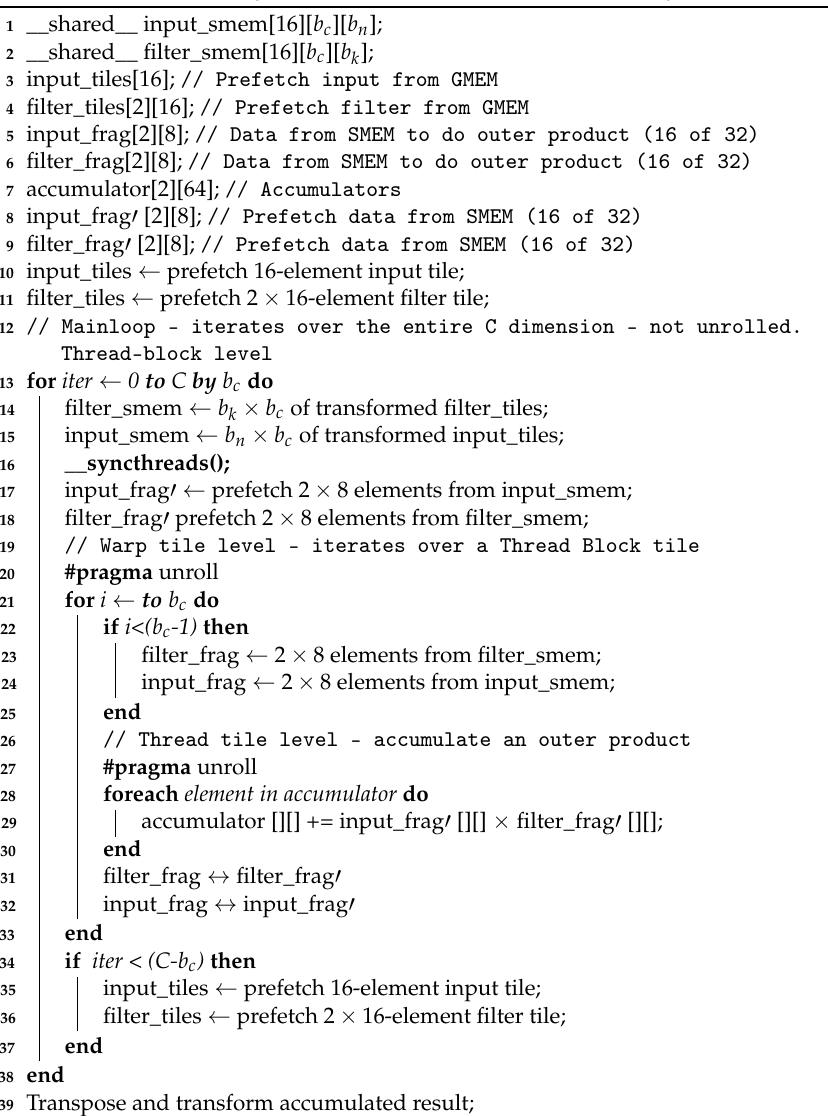
Algorithm 1: Pseudocode of the Winograd’s algorithm implementation for α = 4. SMEM stands for Shared MEMory while GMEM stands for Global